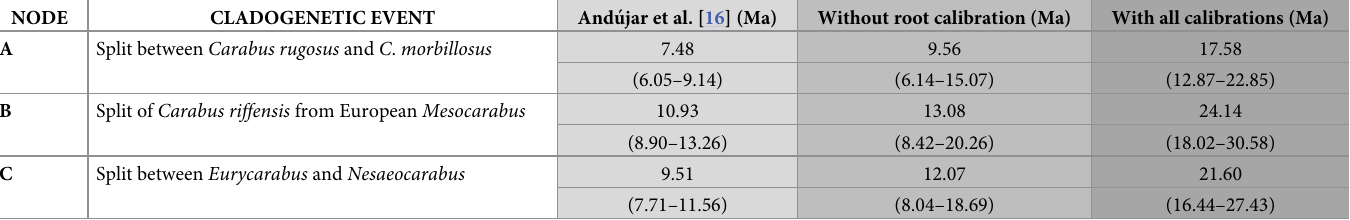
Table 3. Comparison of secondary calibration points derived in this study and in Andu´jar et al. [16] to calibrate the molecular phylogenies of the single (left) and combined datasets (right) in Carabus . NODE CLADOGENETIC EVENT